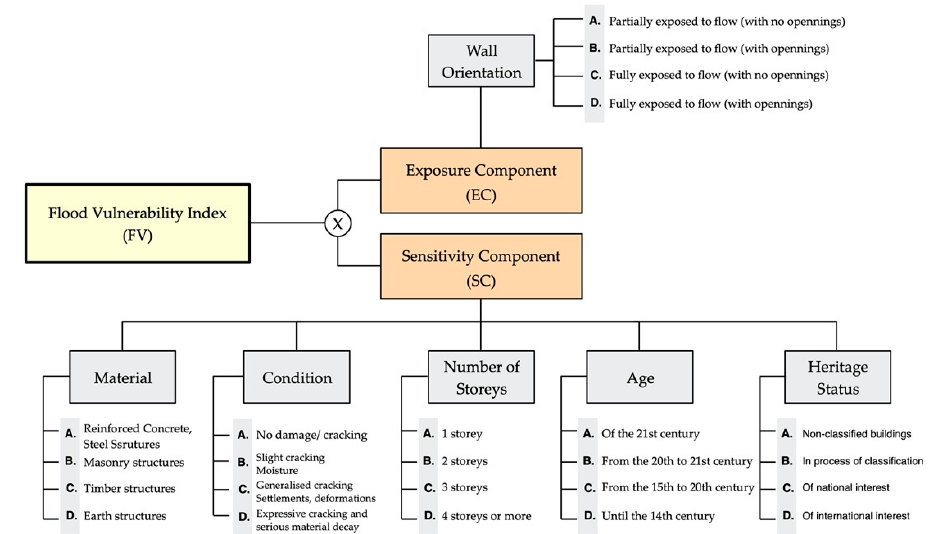
Figure 3. The schematisation of the vulnerability module.